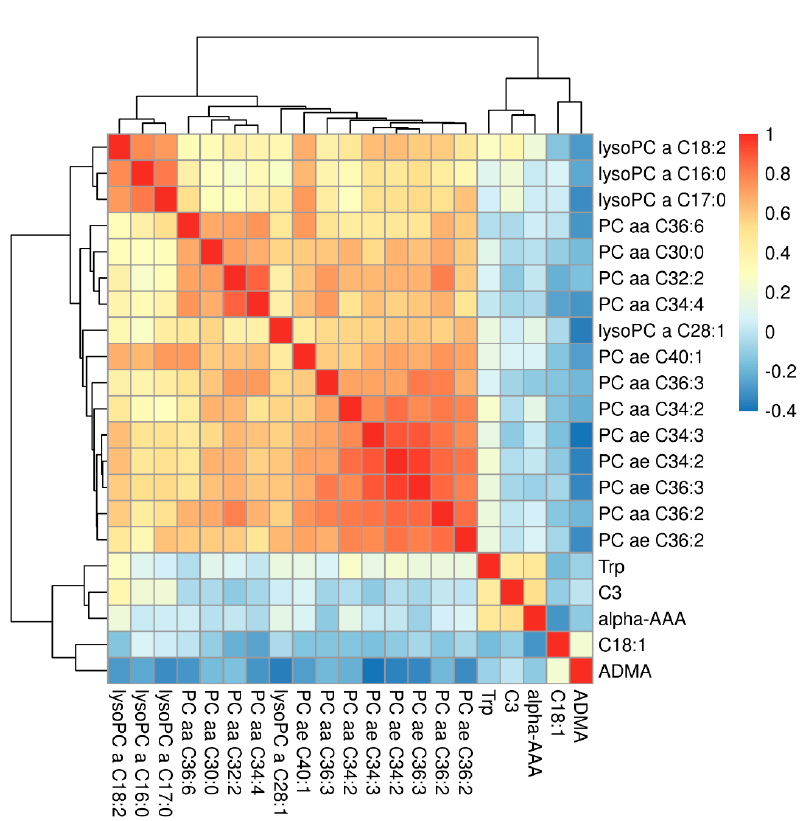
Figure 3. Correlations between significant metabolites.